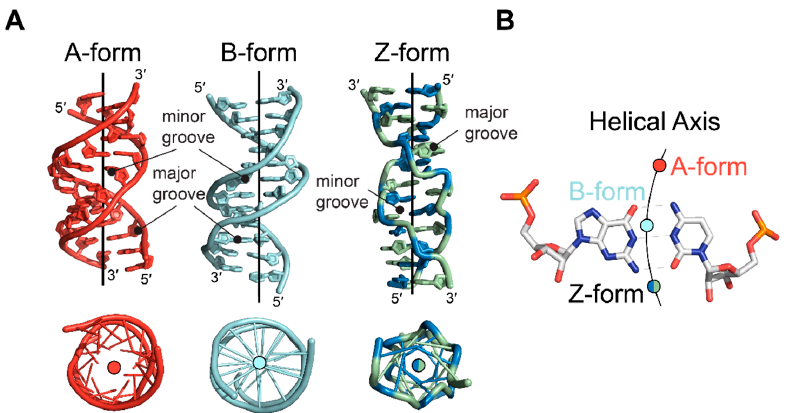
Figure 4. Comparison of helical axes between A-, B-, and Z-form nucleic acids. ( A ) Side ( top ) and top-down ( bottom ) views of A-form (red, PDB: 413D [48]), B-form (cyan, PDB: 6CQ3), and Z-form (green and blue, PDB: 4OCB [49]) nucleic acids. Position of helical axes are drawn as a line for each structure. Below, the structures have been rotated to look down the center of the helix. ( B ) Positions of the helical axes relative to a G • C base pair for the A-form (red circle), B-form (cyan circle), and Z-form (green and blue circle)